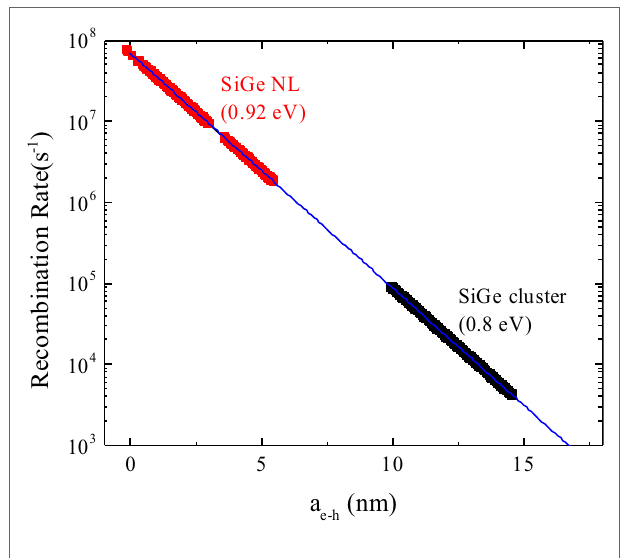
FiGURe 17 | Carrier recombination rates (dots) extracted from the experimental data as a function of the distance between electrons and holes for photon detection energies associated with SiGe NL PL (~ 0.92 ev) and SiGe cluster PL (~ 0.8 ev) . The solid line is the theoretically calculated electron–hole recombination rate (Mala et al.,